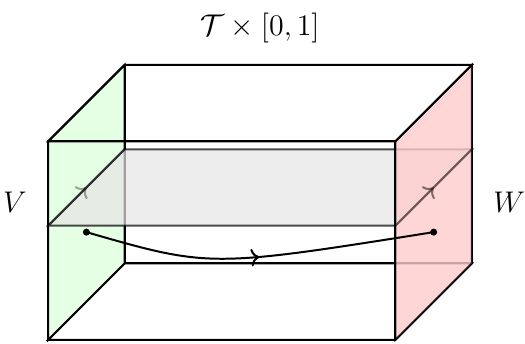
Figure 3 . The figure shows how operators in the 2 d CFT arise from objects in a 3 d bulk theory, which has V and W as